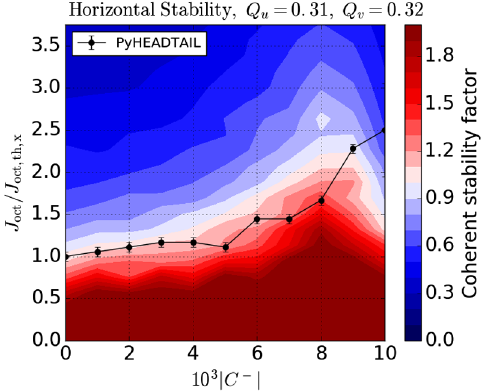
FIG. 8. Stablizing octupole current (normalized to uncoupled value) as a function of the j C − for both P Y SSD (contours) and P Y HEADTAIL. For each step the tunes are kept at constant values of Q u ¼ 0 . 31 , Q v ¼ 0 . 32